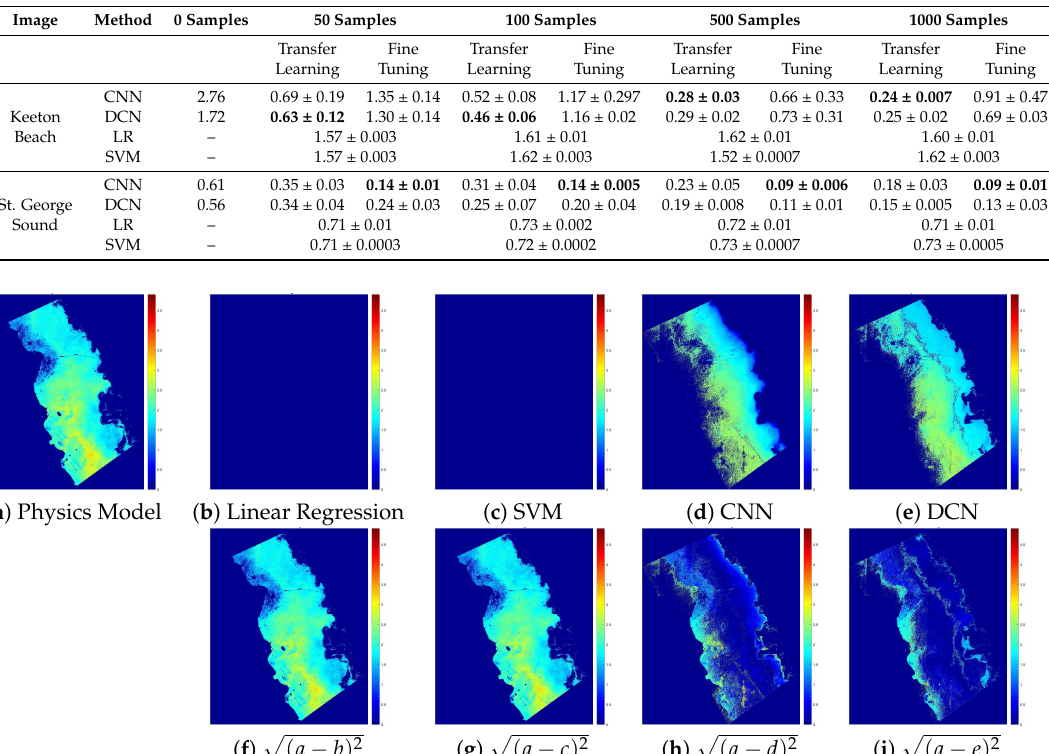
Table 4. RMSEs obtained by our transfer learning approach and fine tuning utilizing different number of samples from new locations. Five experiments are performed for each sample size. The table shows the results as mean ± std. Best results are highlighted in bold.